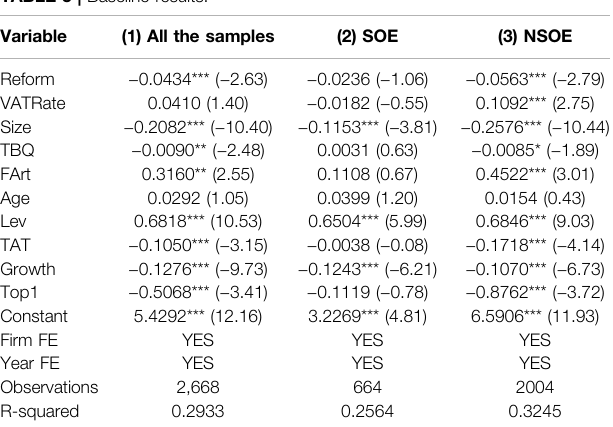
TABLE 3 | Baseline